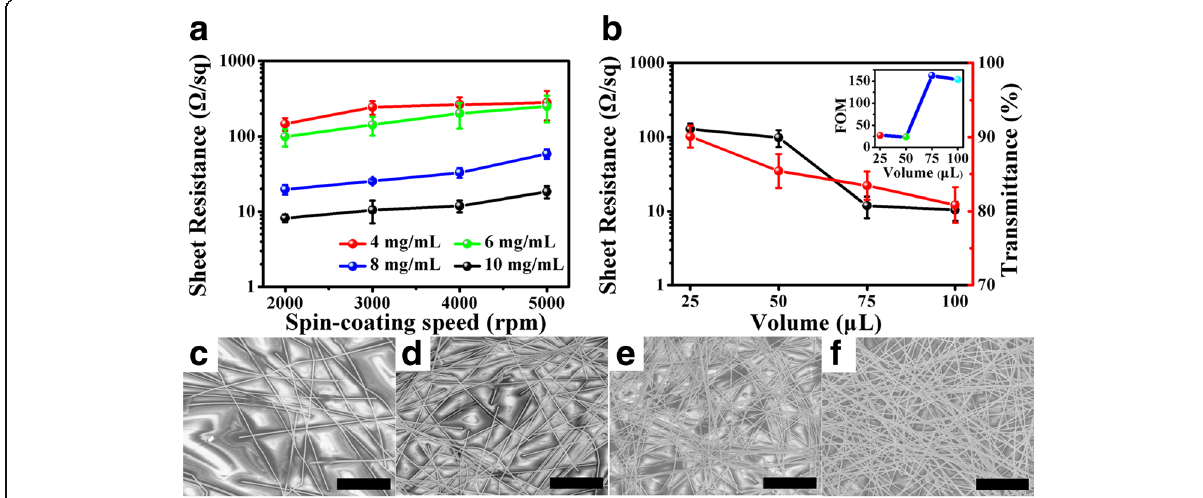
Fig. 5 a Sheet resistance of Ag NWs films vs the spin-coating speed at different concentration of Ag NWs. b Comparison of optoelectronic performance of Ag NTEs fabricated by different volume of Ag NWs solutions. The concentration of Ag NWs solution is 6 mg/mL, and the volume of each spin coating is 25 μ L. The inset is the FOM values of Ag NWs films vs the volume of Ag NWs solution. c – f SEM images of Ag NWs